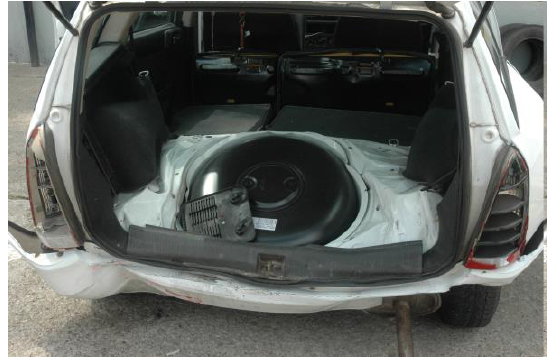
Fig. 10. The rear of a vehicle with a toroidal LPG tank after collision [12] Connectors, nozzles and couplings are made of non- sparking materials (brass), so rubbing is not able to ignite any fuel vapors